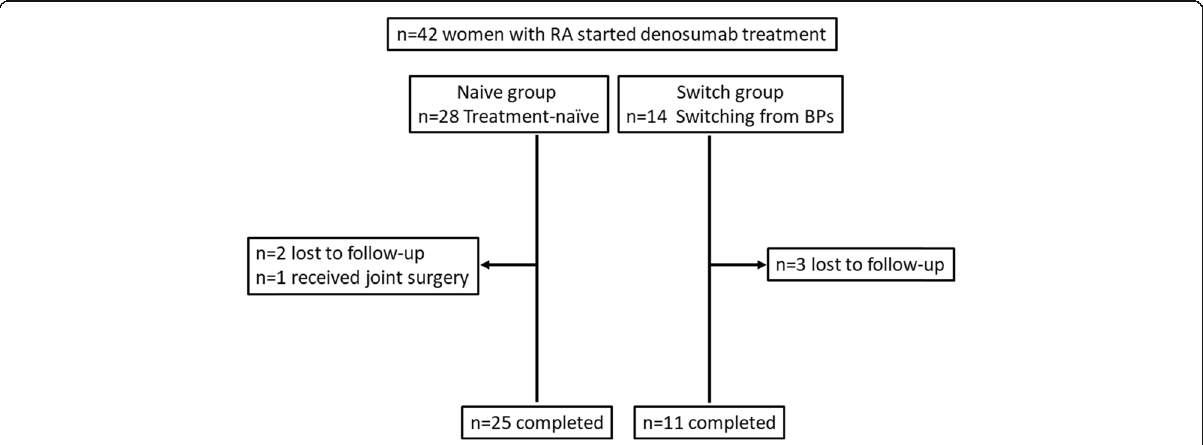
Fig. 1 Trial profile. RA: rheumatoid arthritis; Naive group: treatment-naïve group; Switch group: transitioning from bisphosphonate group; BPs: bisphosphonates